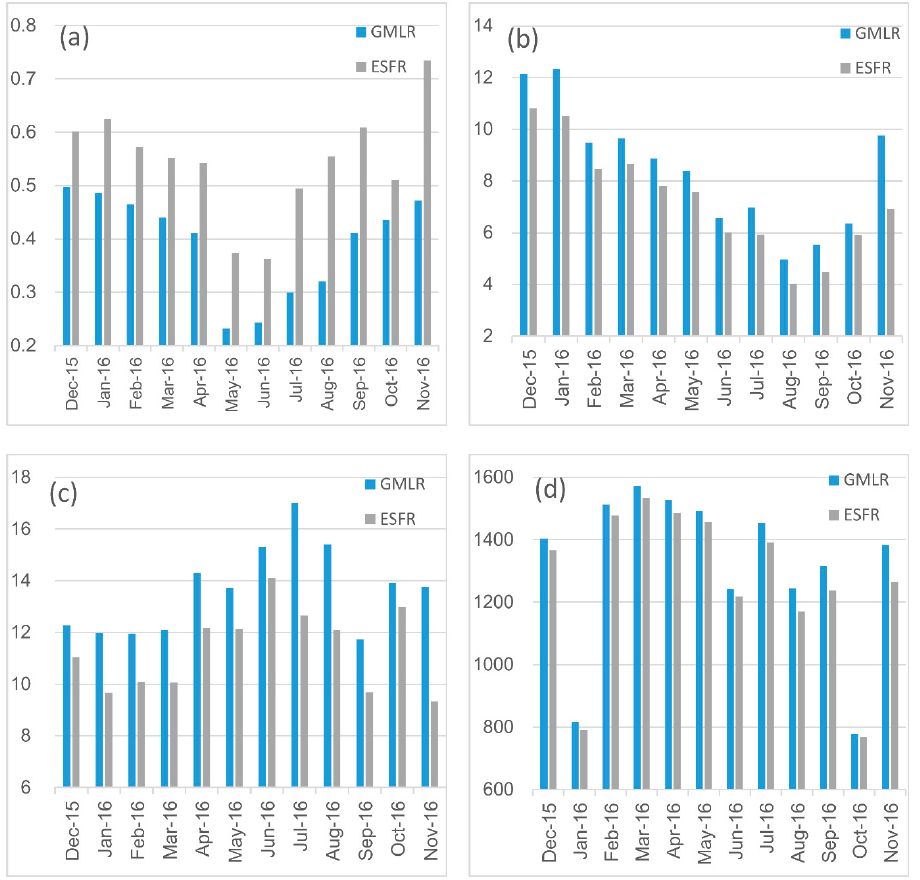
Figure 4. Adjusted R 2 ( a ), RSE ( b ), MAPE ( c ) and AICc ( d ) comparisons among monthly PM 2.5 GMLR and ESFR